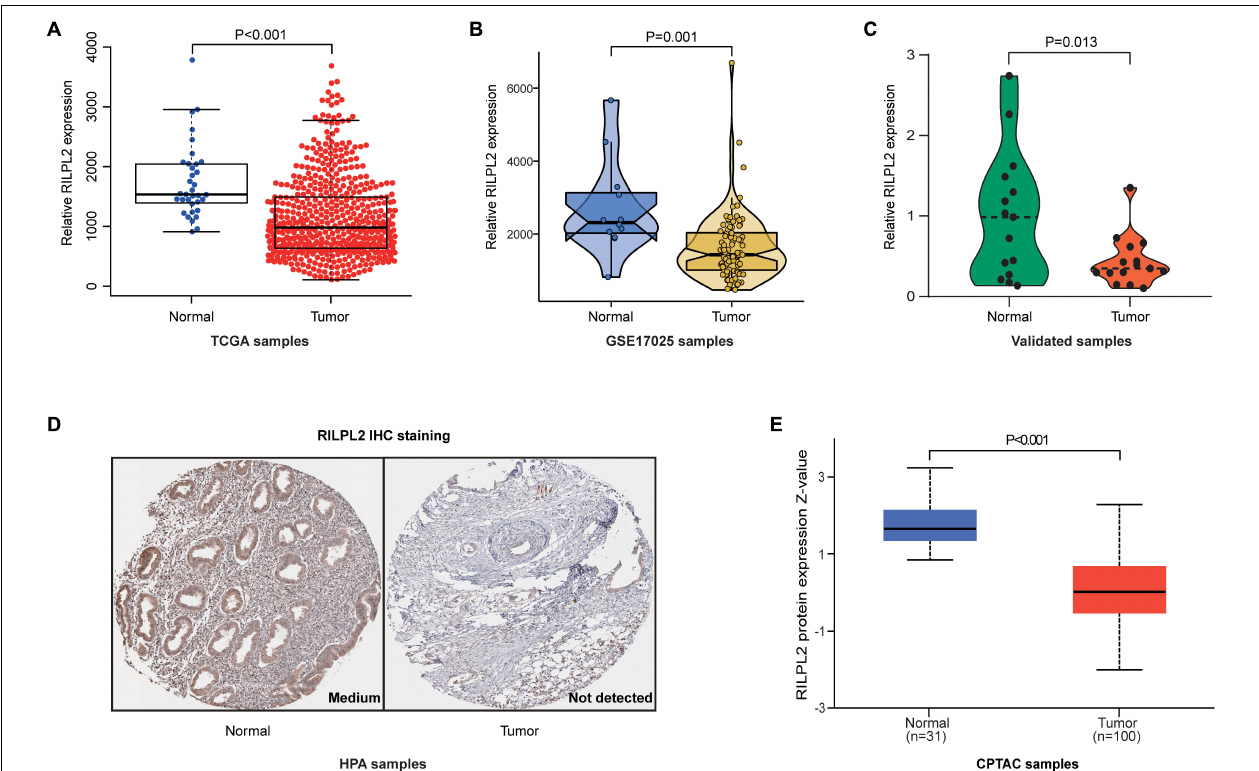
FIGURE 1 | Expression analysis of RILPL2 in EC. (A–C) Differential expression of RILPL2 in tumor and adjacent samples from the TCGA dataset, the GSE17025 dataset, and our recruited cohort. (D) Representative images shows the samples stained with RILPL2 from the HPA database. (E) Differential expression of RILPL2 protein in tumor and adjacent samples from the CPTAC